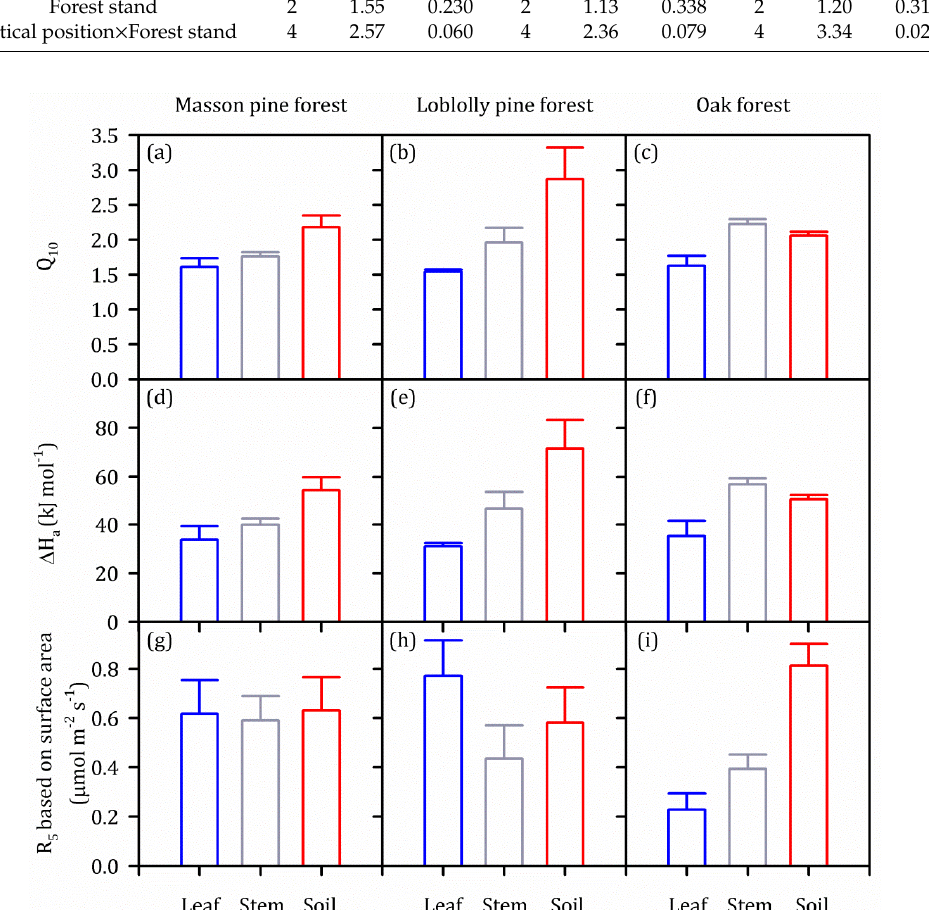
Figure 4. Temperature sensitivity (Q 10 , a – c ), activation energy ( Δ H a , d–f ), and base respiration (R 5 , g– i ) in individual components, including leaf respiration (blue), stem respiration (grey) and soil respiration (red), of ecosystem respiration (ER) for masson pine (left panels), loblolly pine (middle panels) and oak (right panels) forests. Values are means ± SE ( n = 4).